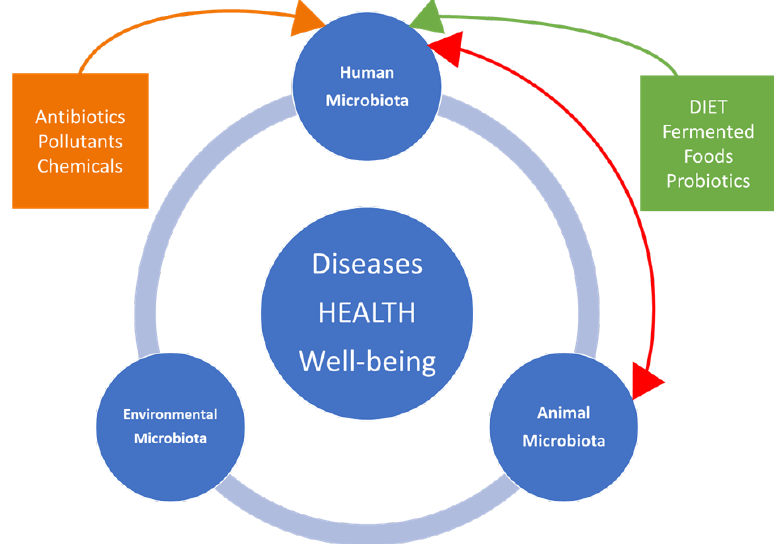
Figure 2. Interactions between dynamics of microbiota in humans, animals, and the associated environment with disease occurrence, salubrity, and well-being.